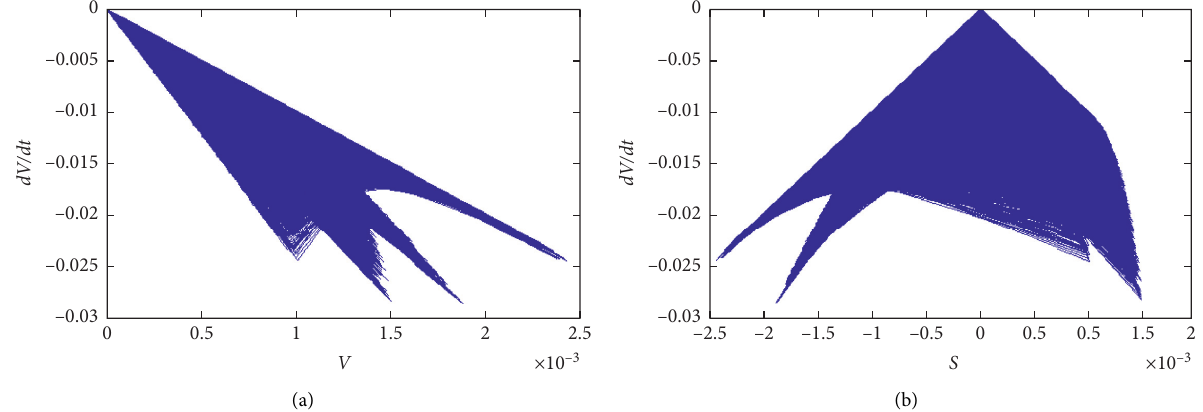
Figure 17: d V /d t versus V and s for the controlled system with η � 10. (a). d V /d t versus V . (b). d V /d t versus s .